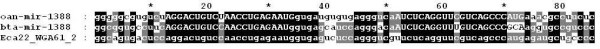
Conserved mir-1388 in three mammalian species. Mature miRNA sequences from bovine (bta) and platypus (oan) are showed in uppercase. Future name is shown as record ID for horse orthologs of mir-1388. Identical base is labeled in black or grey.